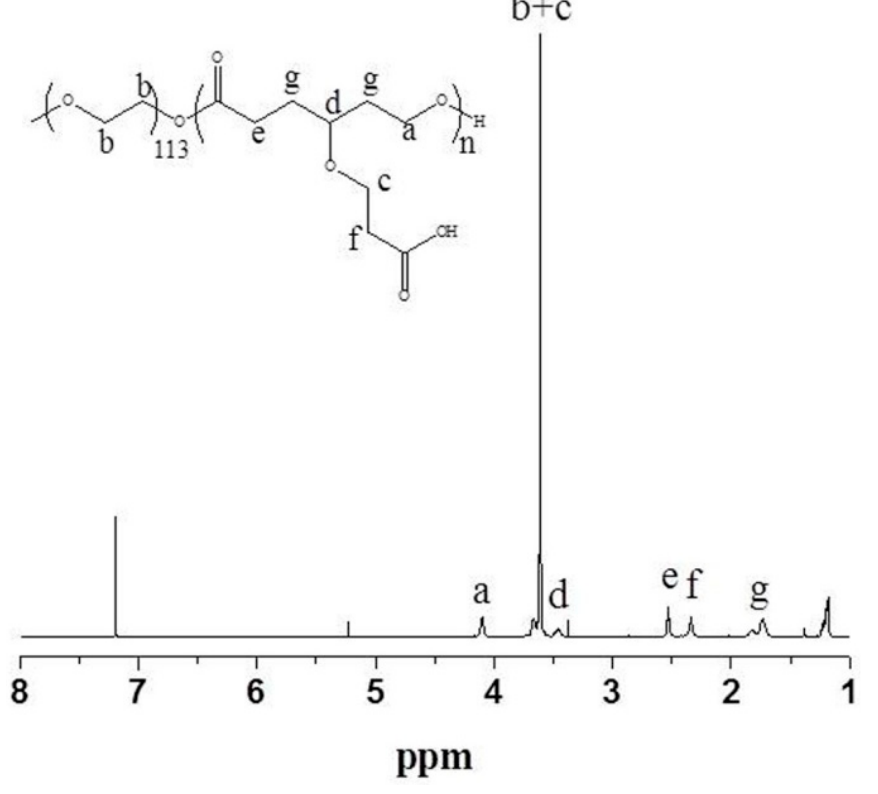
Figure 1. 1 H NMR spectrum of mPEG-CPCL.